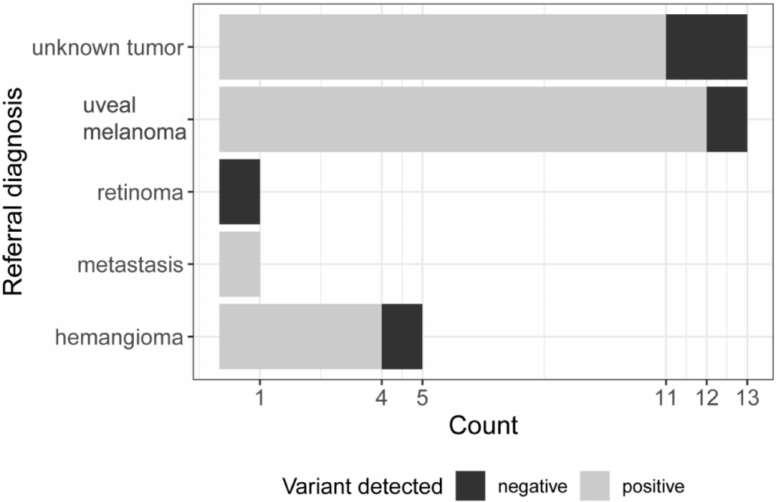
Figure 1. Referral diagnosis. Horizontal bars indicate the number of di ff erent referral diagnoses. Black: negative—no variant detected. Grey: positive—GNAQ p.Q209 variant